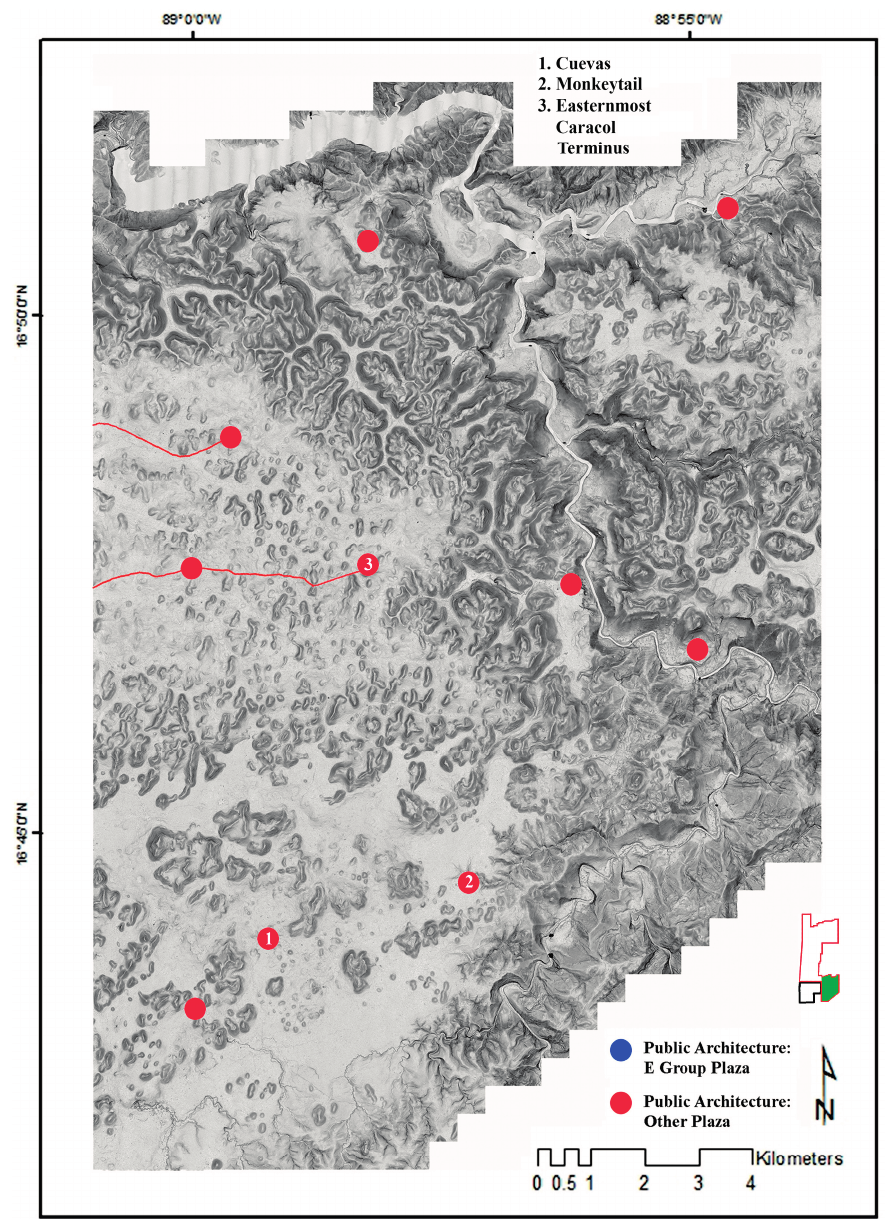
Figure 4. The 2013 LiDAR DEM of the eastern survey area showing the distribution of sites with public architecture and the eastern extent of Caracol, as represented by the continuation of the site’s road systems and three new public plazas. Architectural complexes mentioned by name in the text are numbered. The Chilillo Dam (constraining the Macal River) is in the northern extent of this